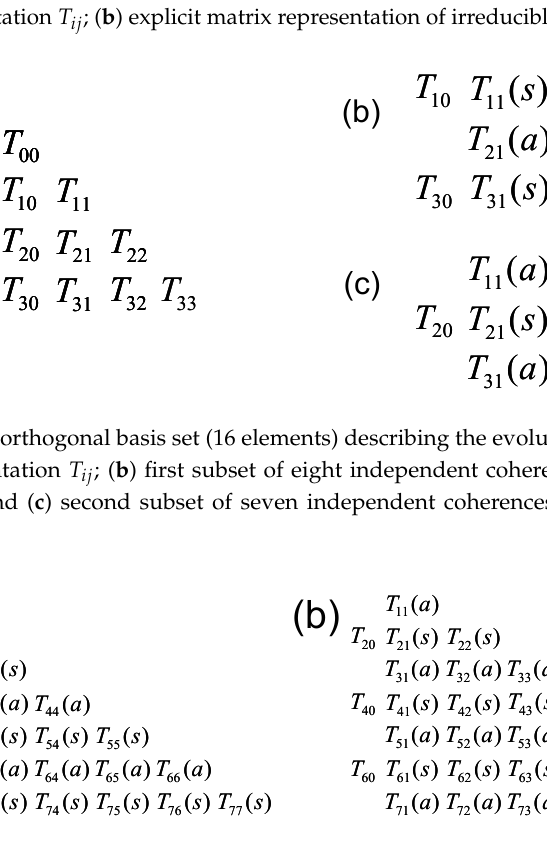
Figure A4. Orthogonal basis set (63 elements) describing the evolution of the spin I = 7/2: ( a ) first subset of 32 independent coherences T ij ( a , s ) including the T 10 coherence; and ( b ) second subset of 31 independent coherences T ij ( a , s ) including the T 20